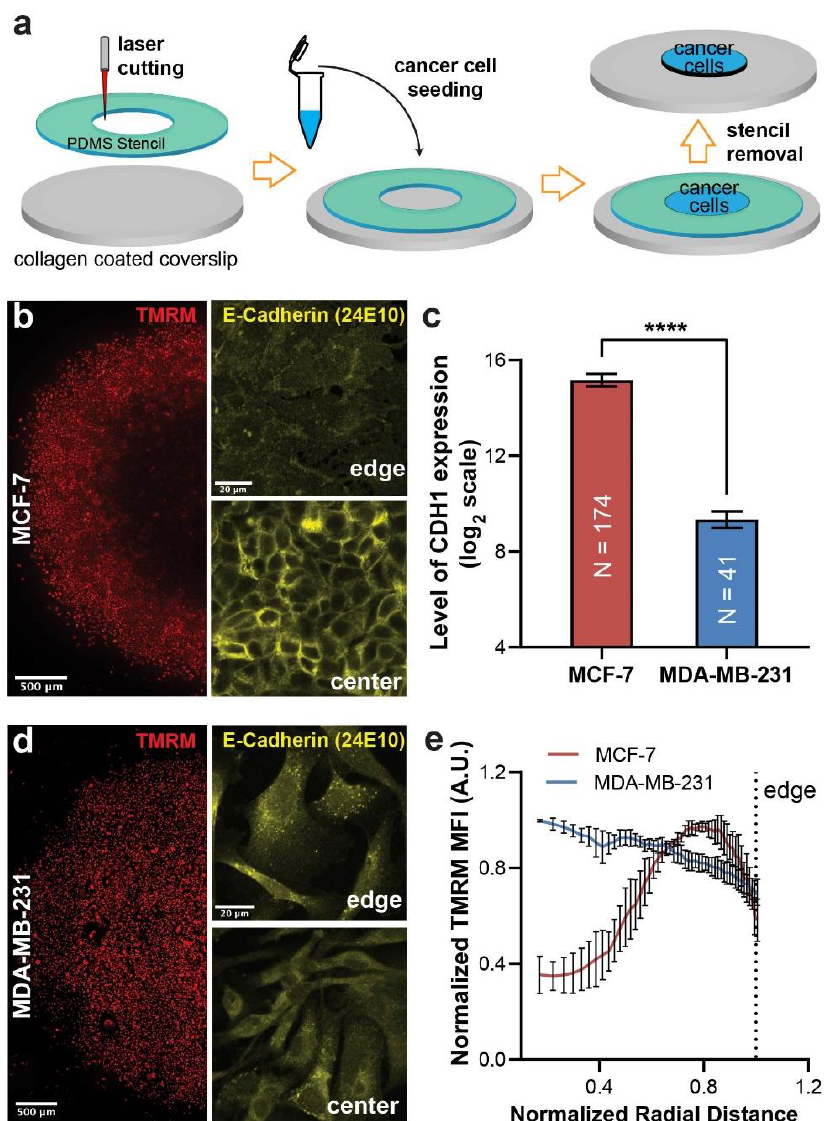
Figure 2. Correlation of E-cadherin expression with spatial distribution of ΔΨ m . ( a ) Schematics of creating an unconfined monoculture micropattern. ( b ) Widefield low-magnification imaging showing spatial distribution of TMRM fluorescence and high-magnification confocal imaging showing E-cadherin localization in day 4 MCF-7 monoculture micropatterns. ( c ) Average E-cadherin (CDH1) expression in MCF-7 cells compared to MDA-MB-231 cells from > 40 independent experiments (obtained from Genevestigator database [27]). **** p < 0.0001 in an unpaired t -test. ( d ) Spatial distribution of TMRM fluorescence and confocal images of E-cadherin staining in day 4 MDA-MB- 231 micropatterns. ( e ) Normalized radial distributions of TMRM fluorescence in day 4 MCF-7 and MDA-MB-231 micropatterns (3 micropatterns per